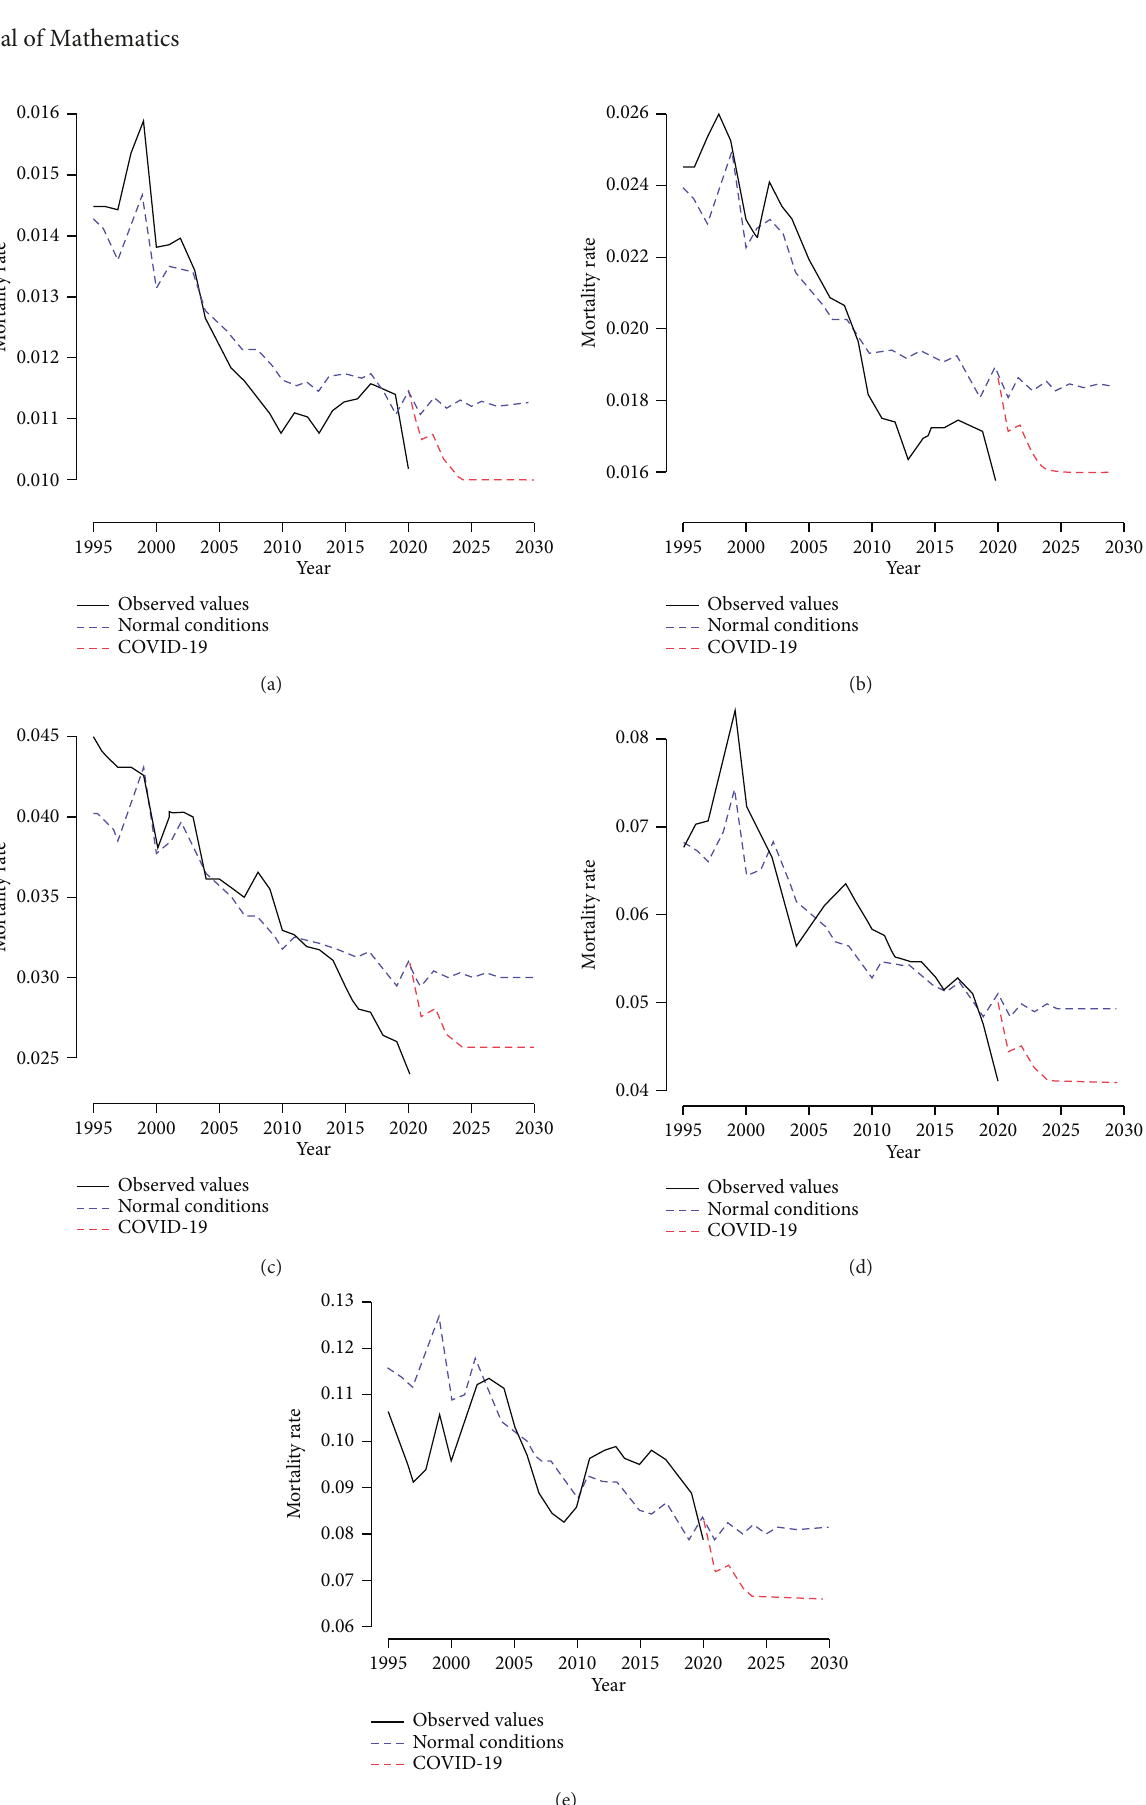
Figure 3: Women’s mortality rate for the age groups of (a) 60–64, (b) 65–69, (c) 70–74, (d) 75–79, and (e)